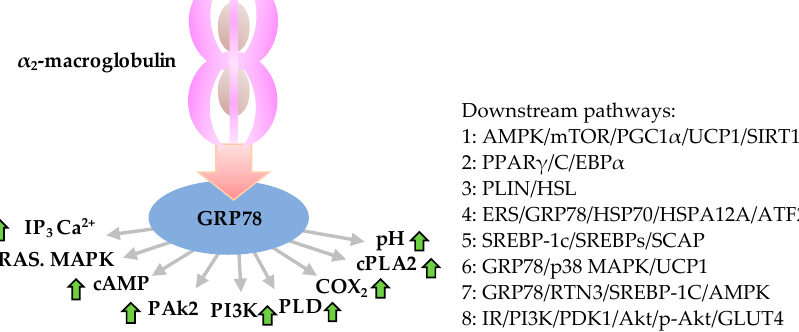
Figure 1. Anti-obesity role of GRP78 and downstream molecular functions associated with obesity . Roles and downstream pathways of GRP78 relevant to obesity initiated by binding of α 2-macroglobulin-GRP78 that triggers the expression of IP 3 , RAS and MAPK, PAk2, PI3K, PLD, COX2, and cPLA2 and increases concentrations of cAMP, Ca 2+ and pH value ( left ), which can activate the downstream pathways ( right ). Green arrows indicate up-expression. AMPK, adenosine monophosphate (AMP) activated protein kinase; Akt, an ubiquitous serine/threonine kinase, also known as protein kinase B (PKB) or RAS-alpha; ATF2, activating transcription factor-2; cAMP, cyclic adenosine monophosphate; C/EBP α , CCAAT/enhancer-binding protein α (which CCAAT is a distinct pattern of nucleotides with GGCCAATCT consensus sequence that occurs upstream by 60–100 bases to the initial transcription site); COX 2 , cicloxigenases; cPLA2, cytosolic phospholipase A 2; ERS, endoplasmic reticulum stress; GLUT4, glucose transporter type 4; GRP78, 78 kDa glucose-regulated protein; HSP70, heat shock protein 70 family; HSL, hormone sensitive lipase; HSPA12A, heat shock protein family a (hsp70) member 12A; IP3, inositol triphosphate; IR, insulin resistance; mTOR, mammalian target of rapamycin; PAk2, p21-activated protein kinase; PGC1 α , PPAR γ coactivator 1 α ; PDK1, pyruvate dehydrogenase kinase 1; PLD, phospholipase D; PI3K, phosphoinositide 3-kinases; PPAR γ , peroxisome proliferator activated receptor γ ; PLIN, perilipin; p38 MAPK, p38 mitogen-activated protein kinases; p-Akt, phosphorylated Akt; RAS, renin-angiotensin system; RTN3, reticular protein 3; SIRT1, sirtuin1; SREBP-1c, sterol regulatory element binding protein-1c; SREBPs, sterol regulatory element binding protein; SCAP, SREBP cleavage-activating protein; TG, triglyceride fatty acid; UCP1, uncoupling protein